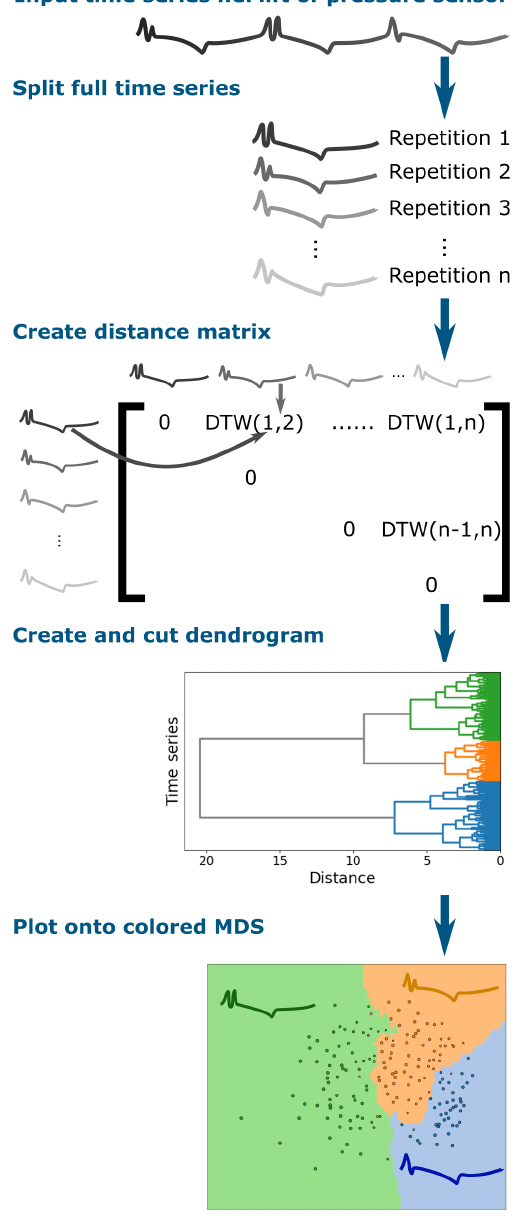
Figure 4. Time series clustering algorithm. Reducing the number of samples gives a significant speed boost as the complexity of the distance measurement is based on the number of time steps. While reducing the sample size, the spectral resolution is reduced about the same factor. The frequency of the expected phenomena limits the amount of downsampling. In order to improve the cluster results the data are, in addition to downsampling, filtered. Dynamic time